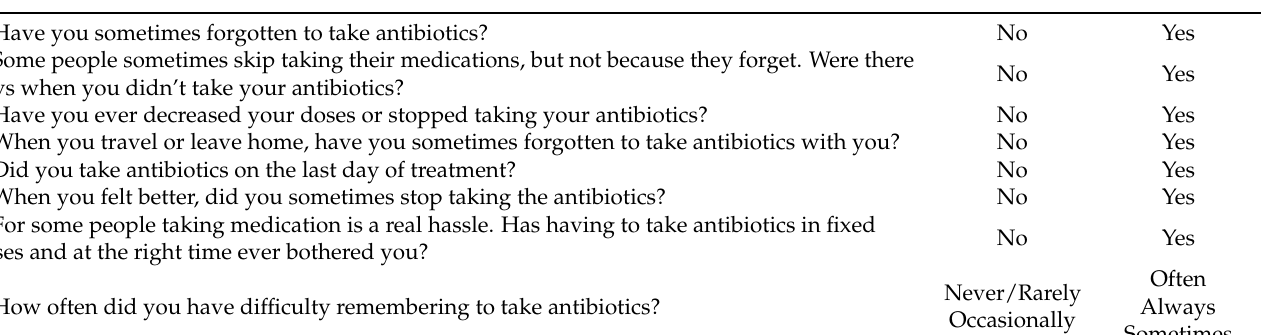
Table 1. Administered questionnaire assessing adherence to antibiotic therapy: modified version of the Morisky Medical Adherence Scale-8 items (MMAS-8)